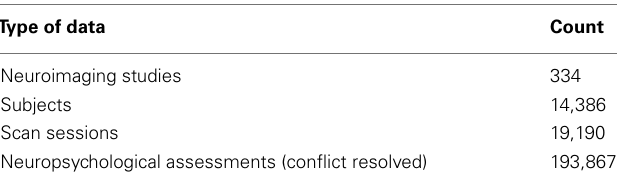
Table 1 |Types of data available to share with other researchers (as of June 12,